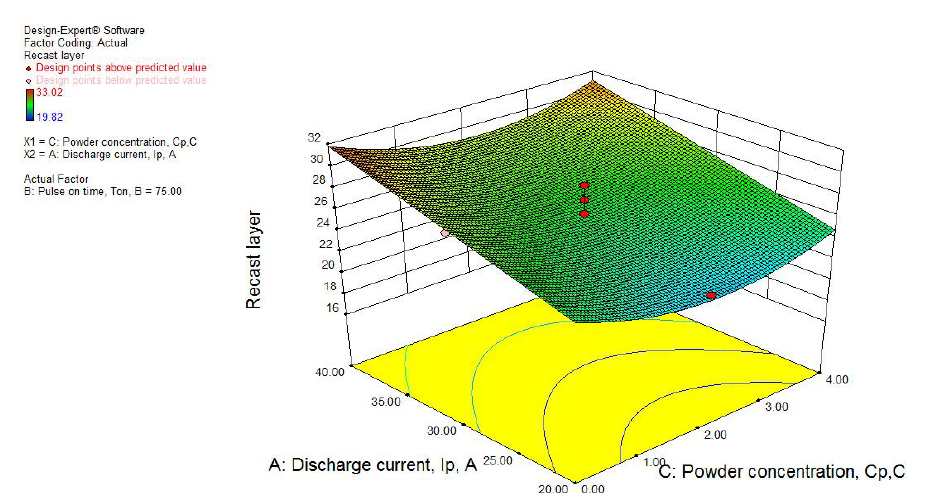
Figure 6: Three dimensional surface graph for recast layer between discharge current and powder concentration